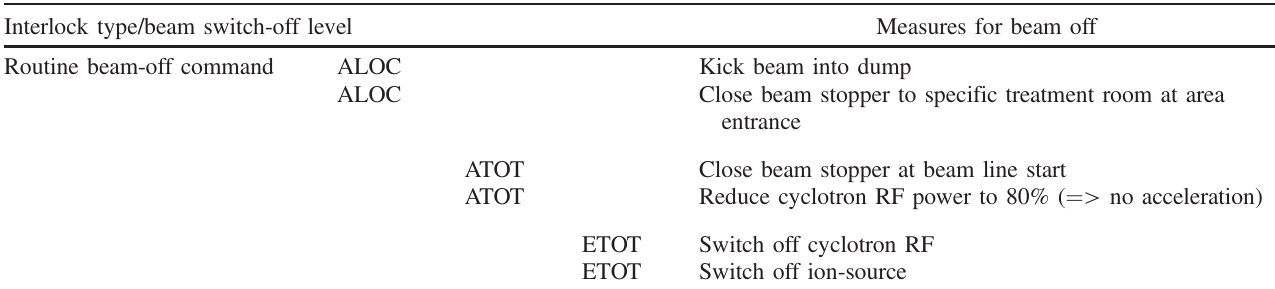
TABLE 2. Hierarchy of the interlock signals of the patient-safety system at PSI to switch the beam off. Interlock type/beam switch-off